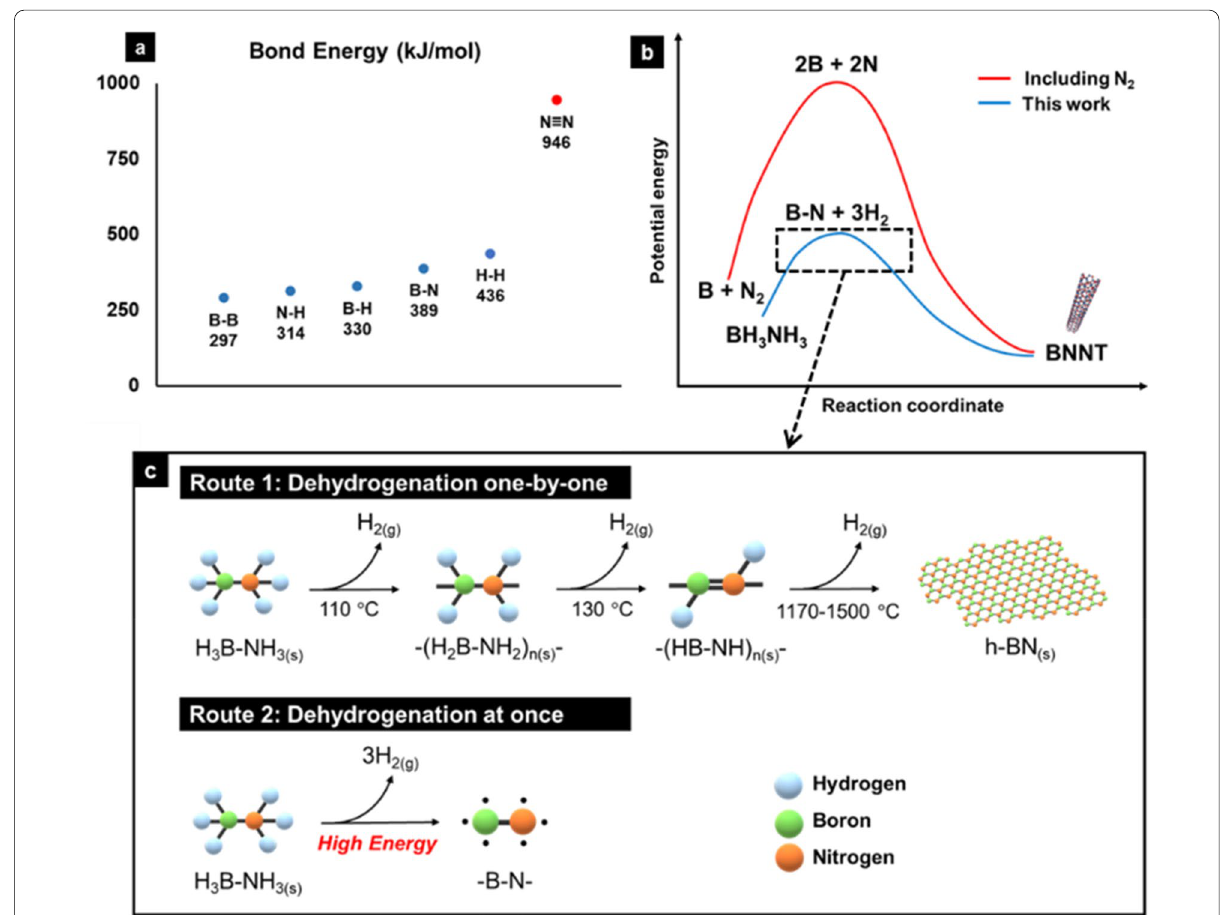
Fig. 1 a Bond energy of bonds consists of B, N or H; b Conceptual energy diagram of BNNT synthesis starting from B different ammonia borane pyrolysis routes according to the dehydrogenation